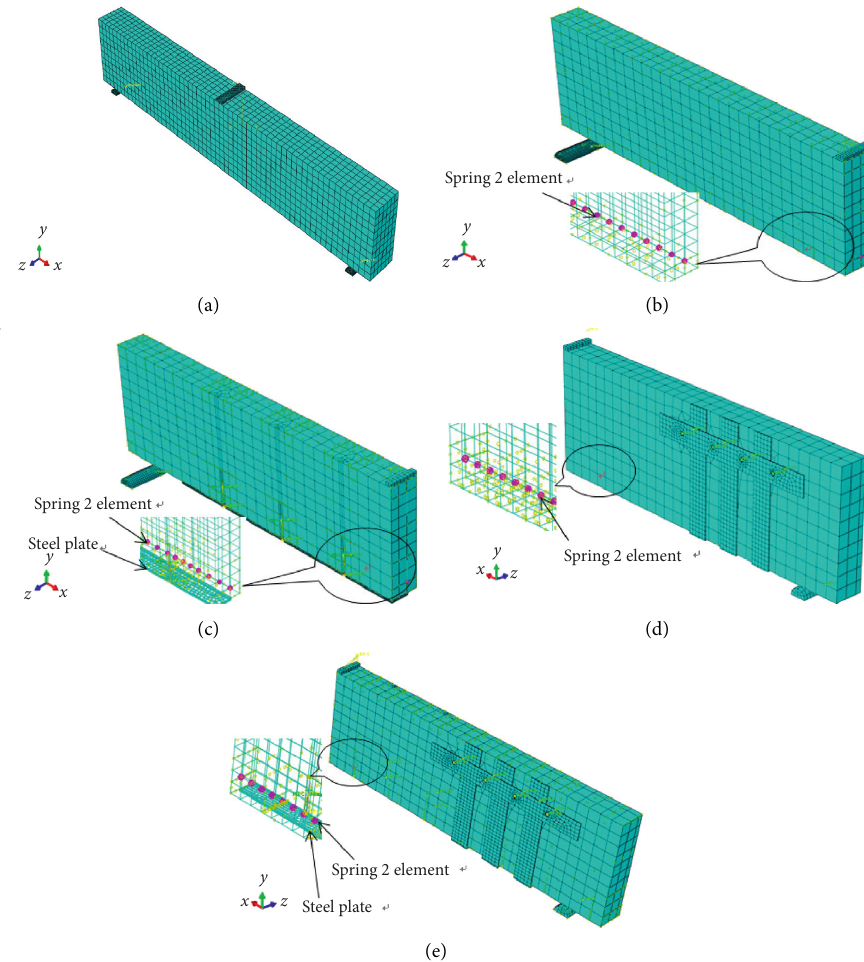
Figure 5: Developed FE models: (a) beam C0C30, (b) beam C10C30, (c) beam S10C30, (d) beam U10C30, and (e) beam